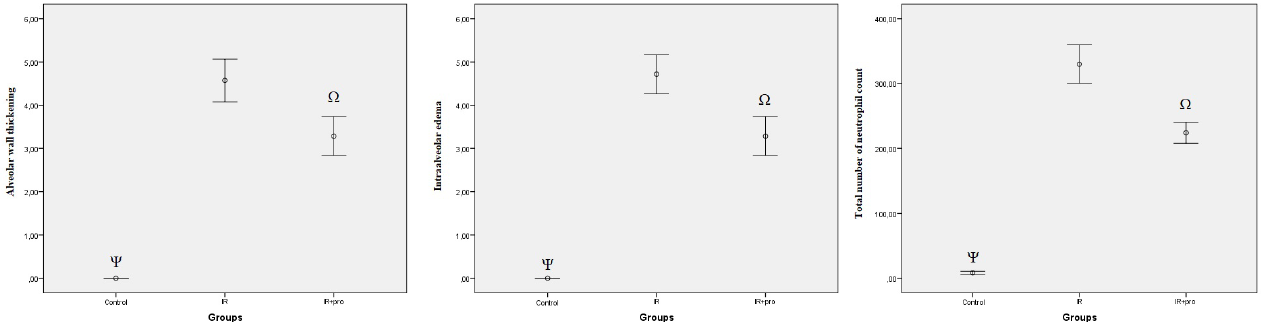
Fig. 4 - Results of histopathological grades of lung tissue and the total number of neutrophil counts. Ψ P<0.05 compared to the IR and IR+Pro groups. Ω P<0.05 compared to the IR